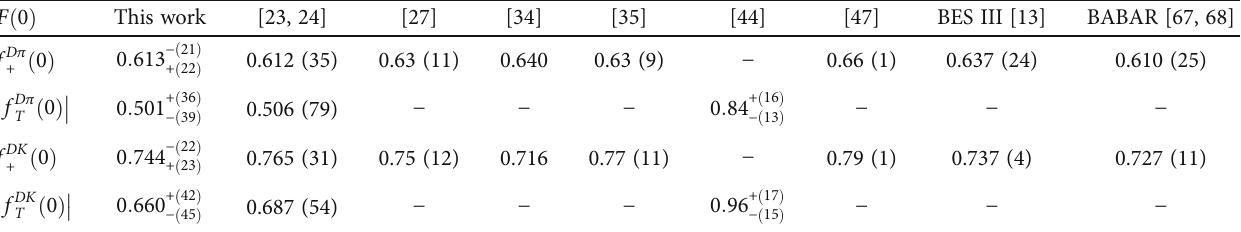
Table 4: Form factors f data.